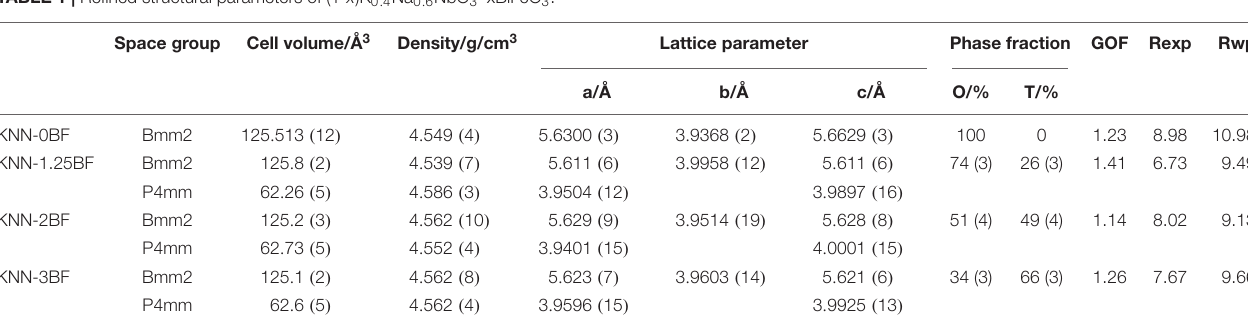
FIGURE 2 | Rietveld refinement analysis of (1- x )K 0 . 4 Na 0 . 6 NbO 3 – x BiFeO 3 ( x = 0, 1.25, 2, and 3 mol.%) using the GSAS + EXPGUI package. TABLE 1 | Refined structural parameters of (1- x )K 0 . 4 Na 0 . 6 NbO 3 –xBiFeO 3